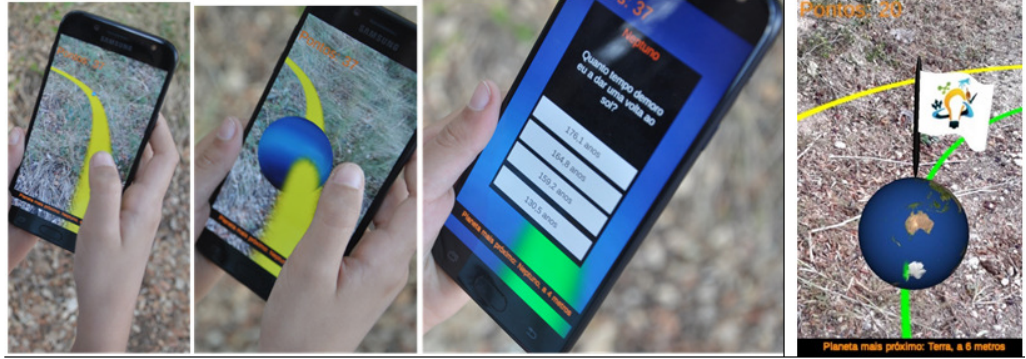
Figure 11. Finding the orbit, hunting the planet and answering the question. Player on the left has 37 points. Neptune’s question: How long is my travel around the Sun?